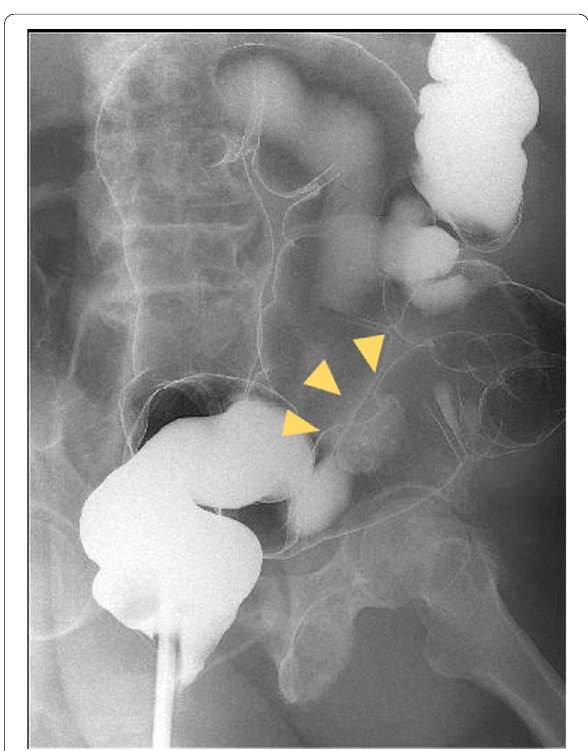
Fig. 2 Radiographic contrast enema findings. A 3-cm stricture can be seen in the sigmoid colon, and the apple core sign is positive (yellow arrow)